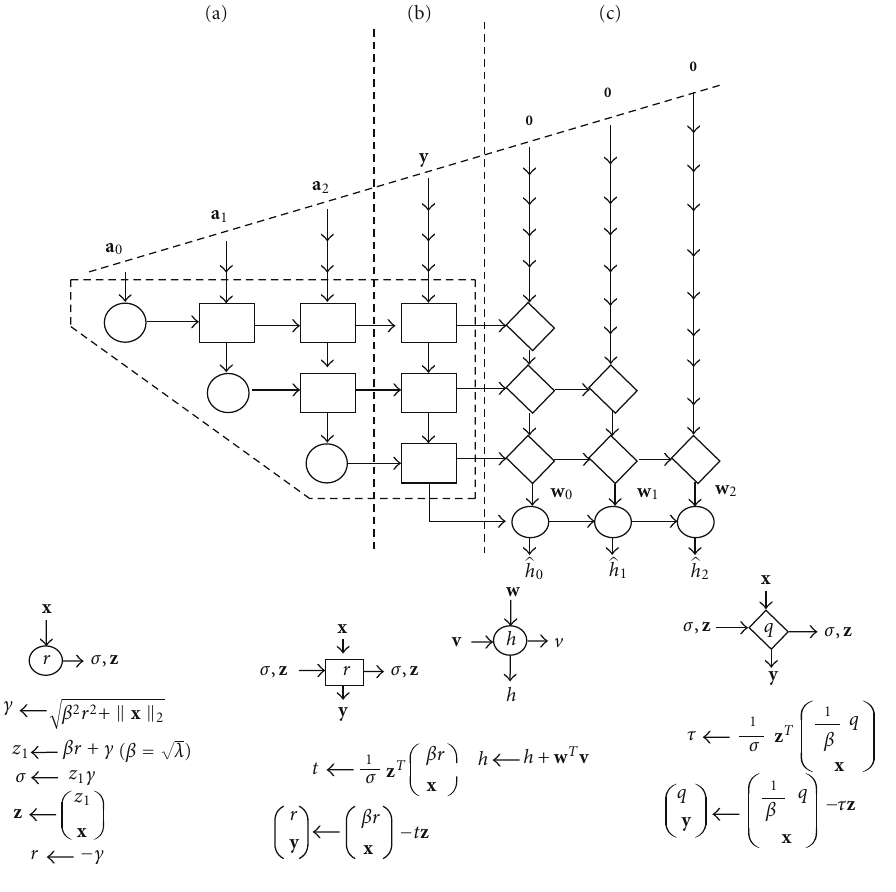
Figure 3: Systolic array implementation of channel estimation section of CPE3 (using Householder transformations) with processing cell descriptions.